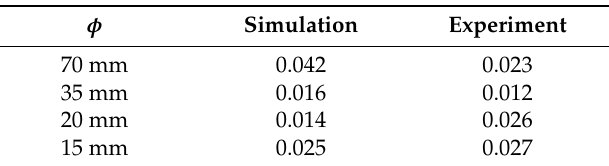
Table 2. Root-mean-square error (RMSE) between the measured and simulated ε (cid:48) values for measurements in containers with different diameters (in mm) and the accepted value for isopropanol in the literature [25]. φ